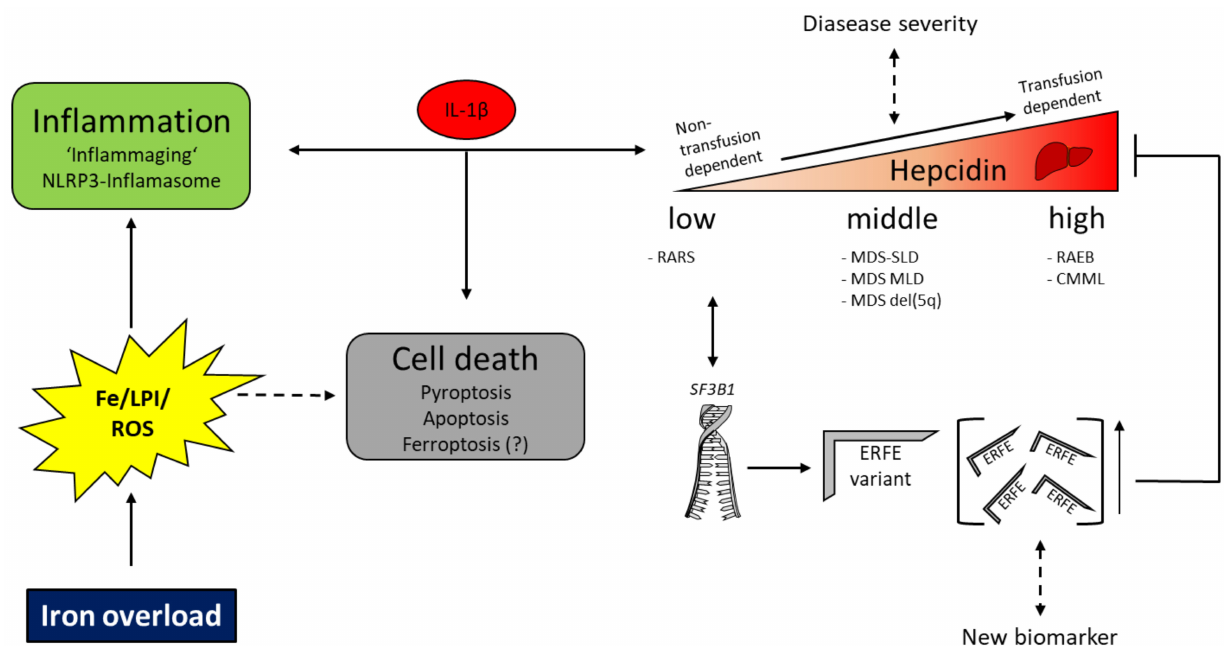
Figure 3. Interaction between iron, inflammation and hepcidin in patients with MDS. Dashed lines indicate a yet un- clear interrelation. Myelodysplastic syndrome (MDS); hematopoietic stem cell (HSC); iron (Fe); reactive oxygen species (ROS); acute myeloid leukemia (AML); erythroferrone (ERFE); single lineage disease (SLD); multilineage disease (MLD); refractory anemia with ring sideroblasts (RARS); refractory anemia with excess blasts (RAEB); chronic myelomonocytic leukemia